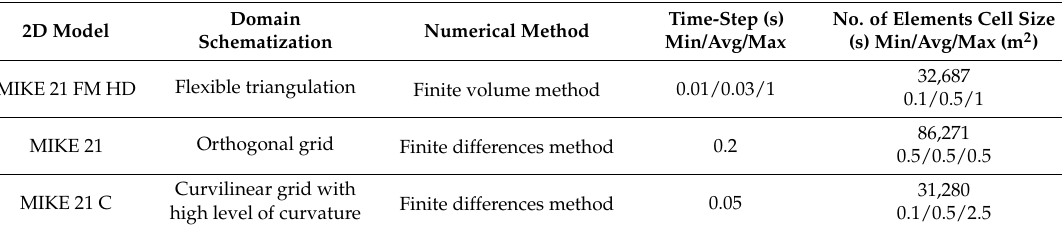
Table 2. Different characteristics of the model domain setup.